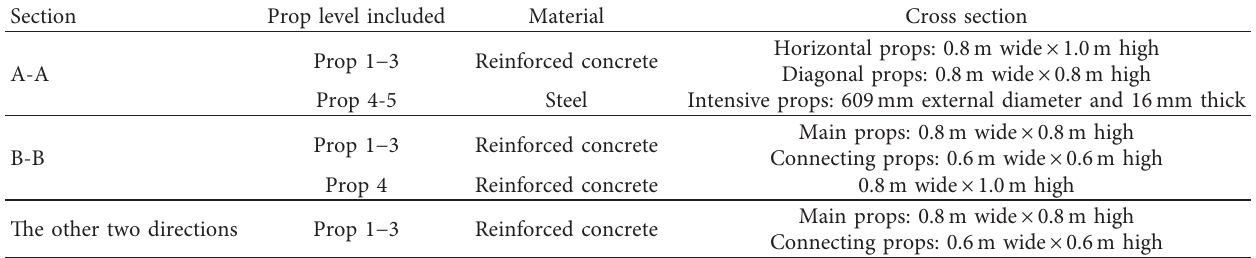
Table 2: Materials and dimensions for each layer of support in all directions.